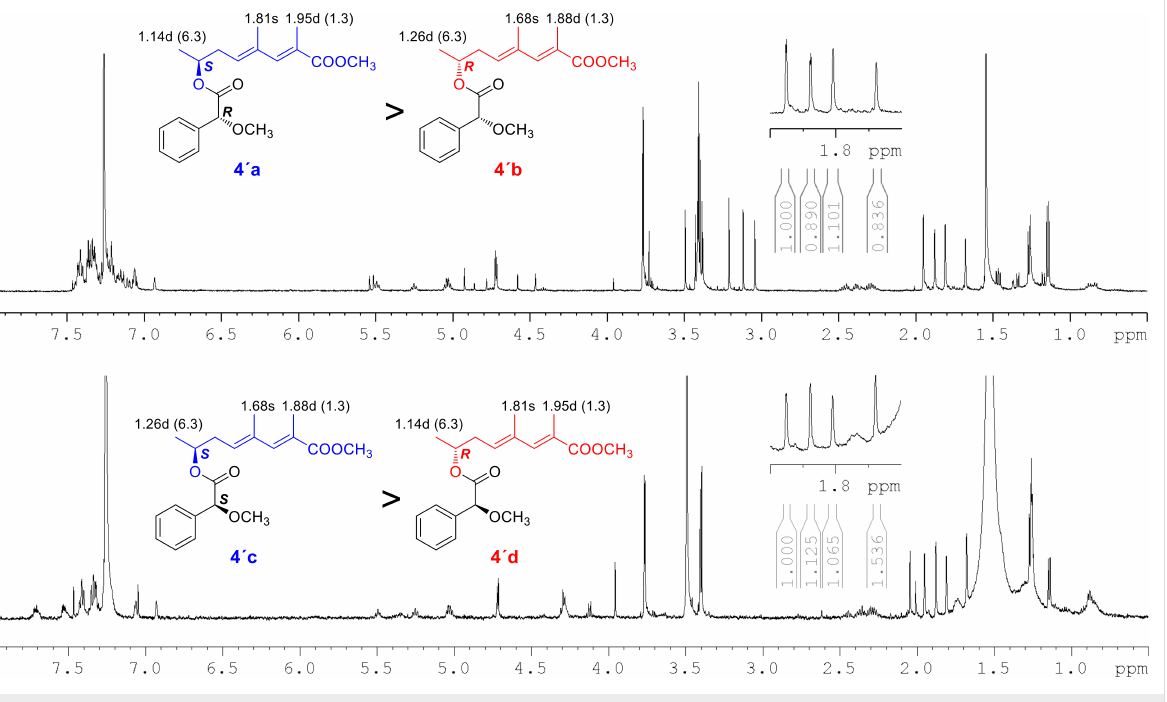
Figure 3: 1 H NMR spectra and partial chemical shift assignments for MPA esters 4'a – 4'd . Upper: ( R )-MPA acylation products, Lower: ( S )-MPA acyl- ation